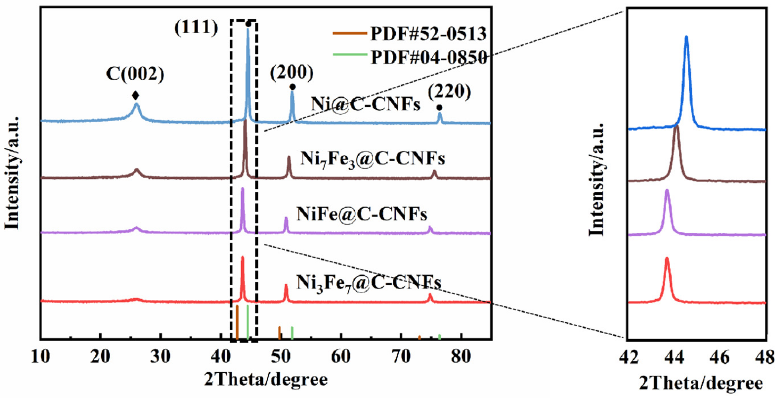
Figure 1. Schematic illustration of the synthesis process of the Ni x Fe y @C-CNFs. The controllable synthesis and compositions are confirmed by XRD measurements as Figure 2. Compared with the diffraction peaks of Ni and Fe, the diffraction peaks of